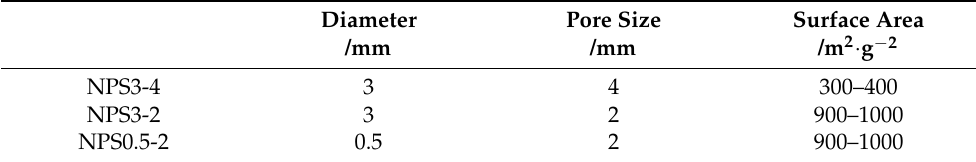
Table 1. The three types of NPS